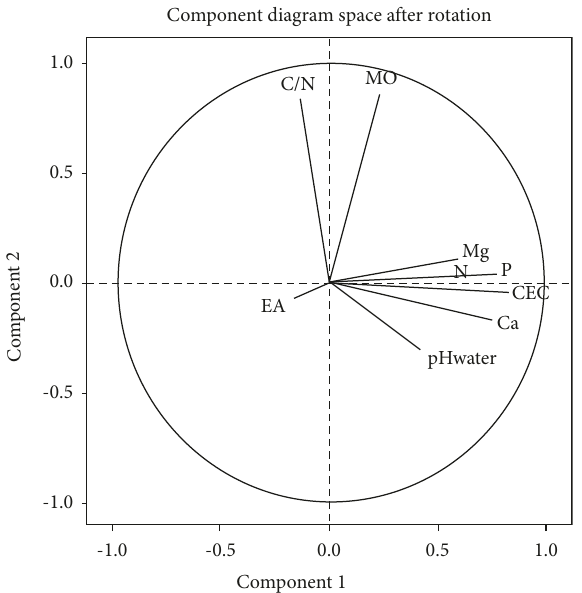
Figure 4: Diagram of components in the ACP area: analysis of partial components; OM: organic matter, C/N: mineralization rate, EA: exchangeable aluminum, pHeau, N: nitrogen, Mg: magnesium, CEC: cation exchange capacity, Ca: calcium, and K: